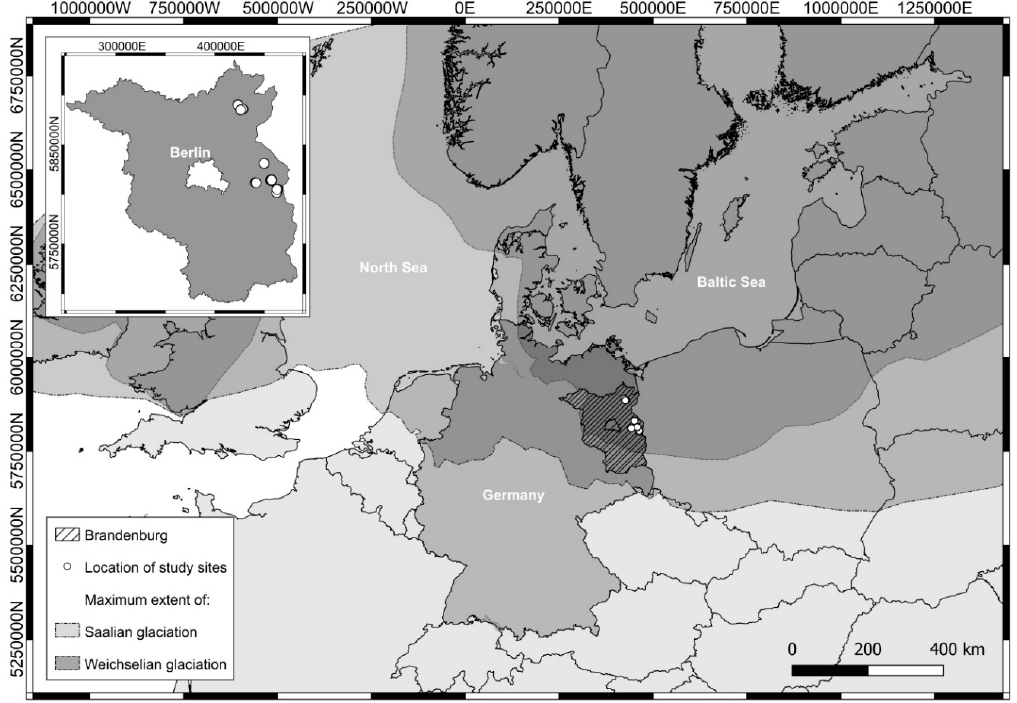
Figure 1. Map of Central Europe with the location of the study sites in the federal state of Brandenburg (Germany) that was largely influenced by the Saalian and Weichselian glaciation at the end of the Pleistocene (Projection: UTM ETRS89 33N) (after [33–35]). The inlay map indicates the detailed location of the study sites.